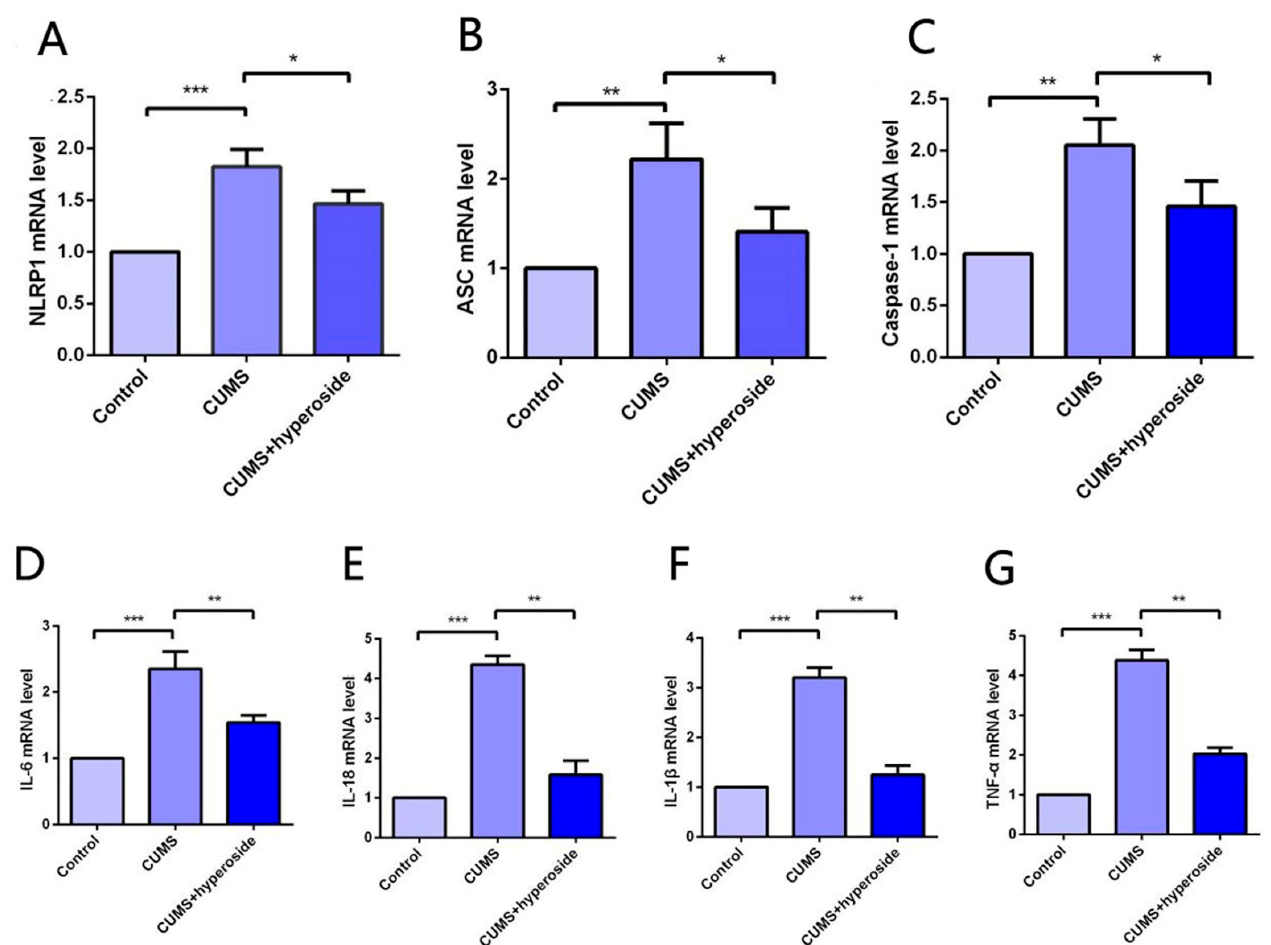
Figure 7. Hyp reduced NLRP1 inflammasome activation and inflammatory response in the hippocampus of chronic-stress-induced mice. ( A – C ) Statistical results show that Hyp decreased the mRNA expression of ( A ) NLRP1, ( B ) ASC, and ( C ) caspase-1 in the hippocampus of chronic stress- induced mice. ( D – G ) Statistical results show that Hyp reduced the mRNA levels of ( D ) IL-6, ( E ) IL-18, ( F ) IL-1 β , and ( G ) TNF- α in the hippocampus of chronic-stress-induced mice. Results are shown as the mean from multiple experiments, n = 5, one-way ANOVA, followed by Dunnett multiple comparison test; * p < 0.05, ** p < 0.01, and *** p < 0.001.